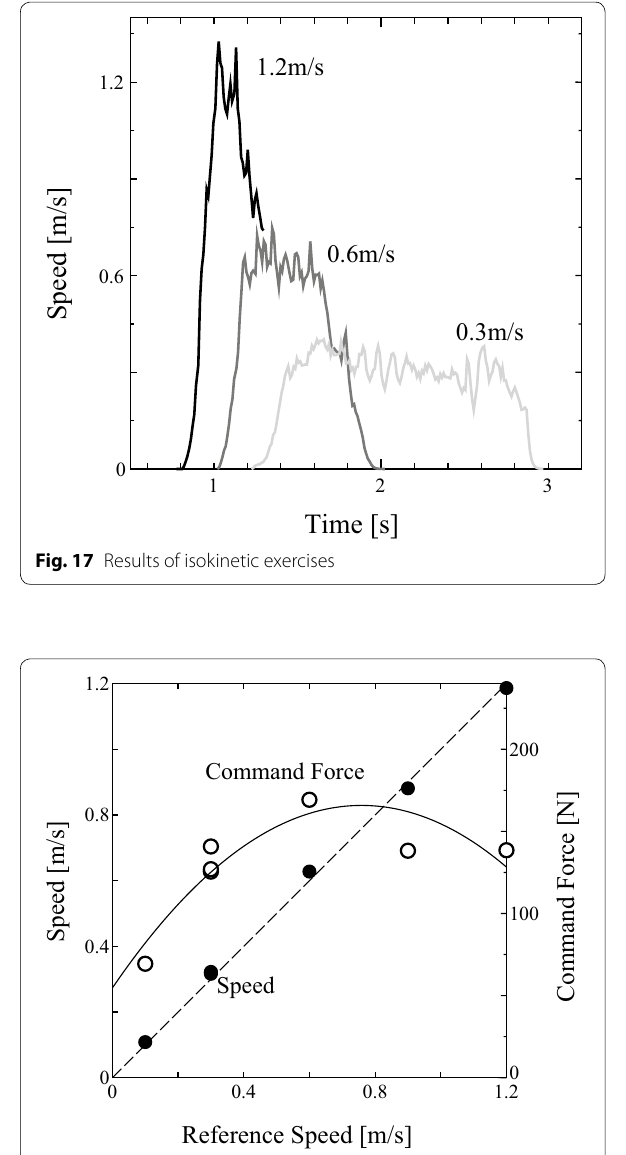
Fig. 18 Mean speed values and command values of resistant force in isokinetic